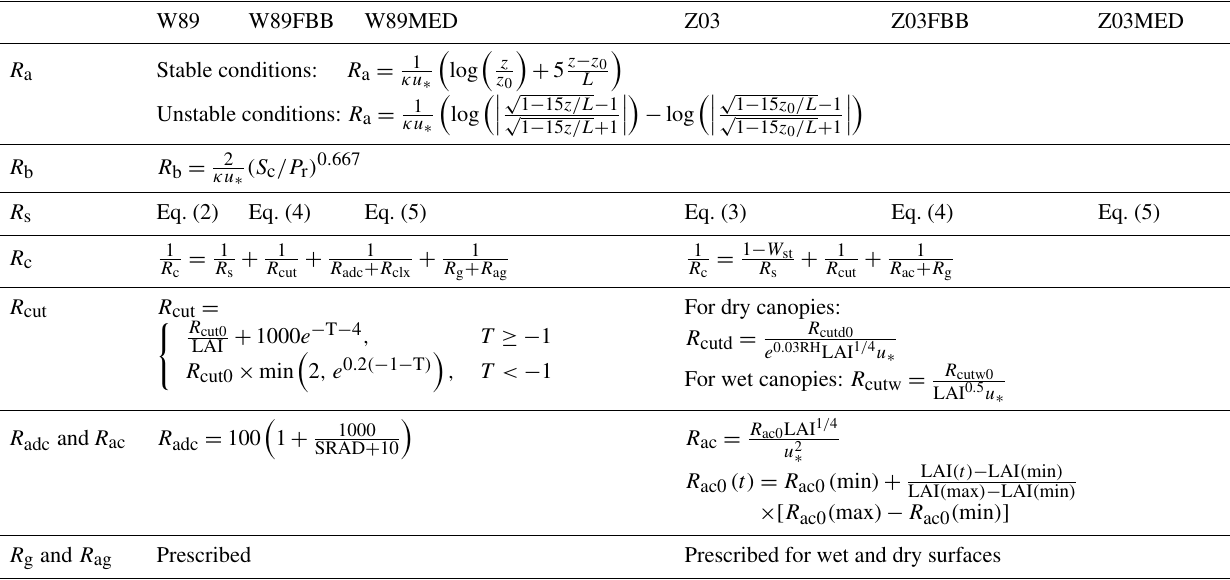
Table 1. Description of dry deposition configurations used in this study.